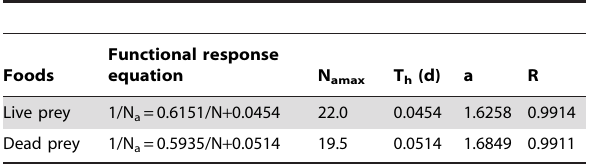
Table 3. Functional response parameters of Pardosa astrigera reared to maturity with live and dead prey.